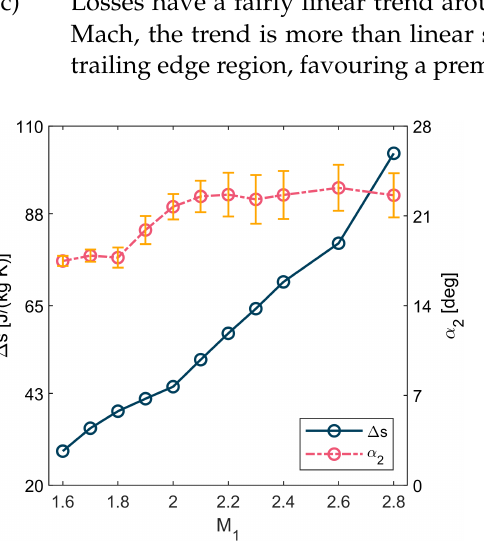
Figure 15. Stator entropy production and outlet flow angle with its standard deviation calculated at the outlet section mid-span for various inlet Mach